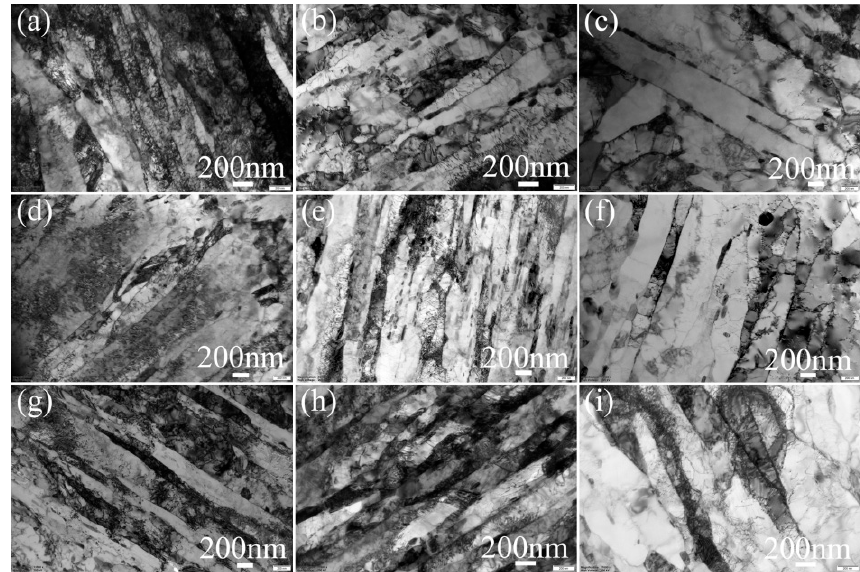
Figure 3. TEM micrographs of 15Cr12MoVWN steel under conditions of ( a ) 0W. ( b ) 0O. ( c ) 0A. ( d ) 5O. ( e ) 5A. ( f ) 5W. ( g ) 8A. ( h ) 8W. ( i ) 8O.